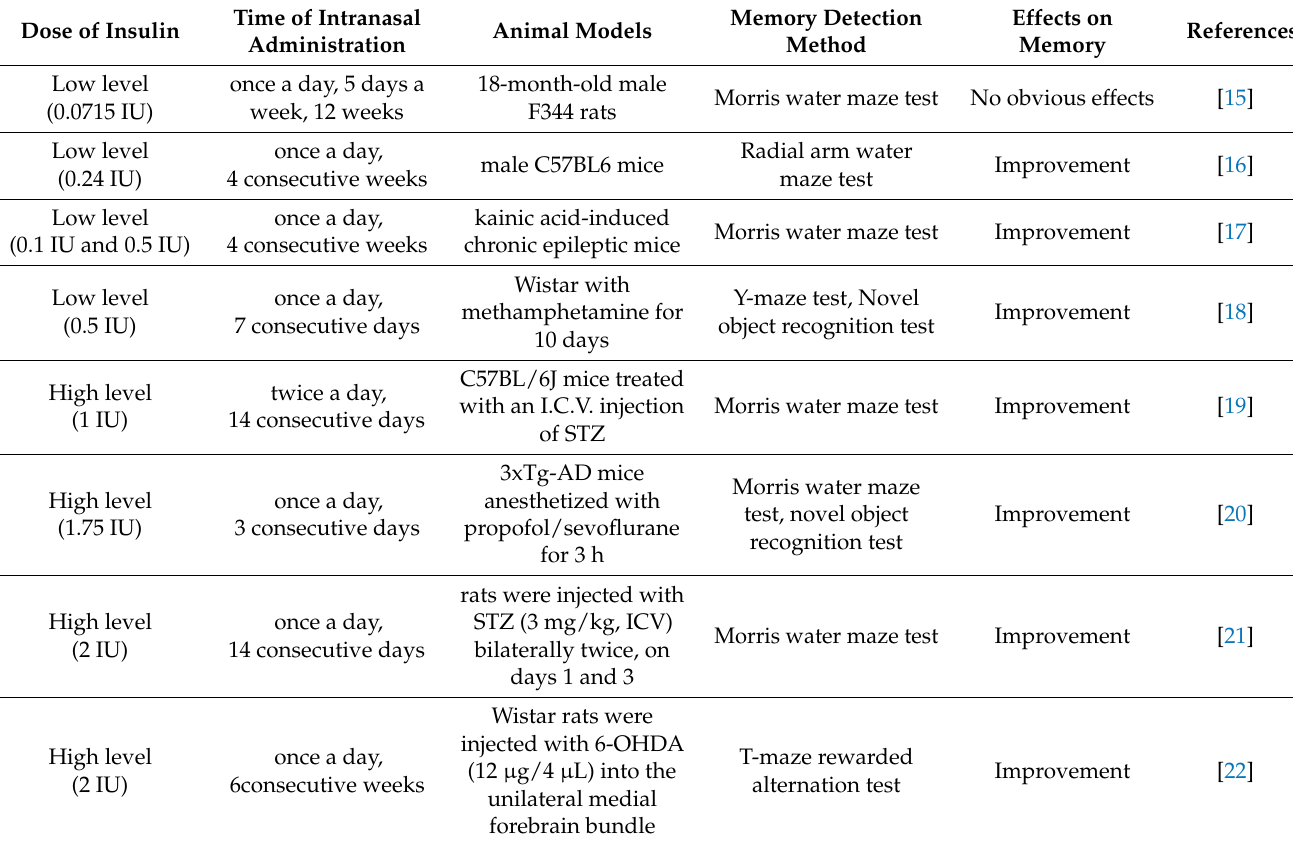
Table 1. Evidence in animal